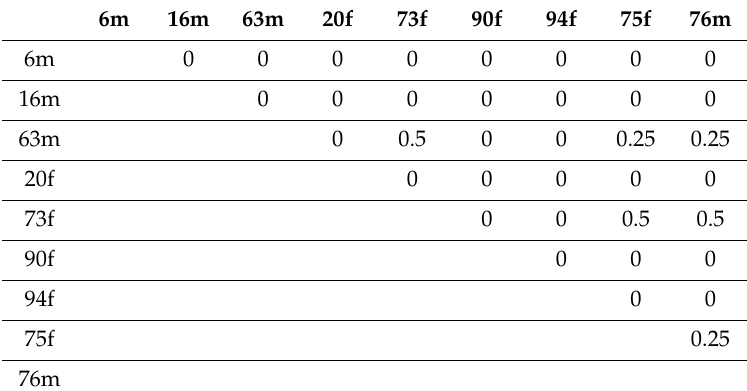
Table 1. Kinship matrix.